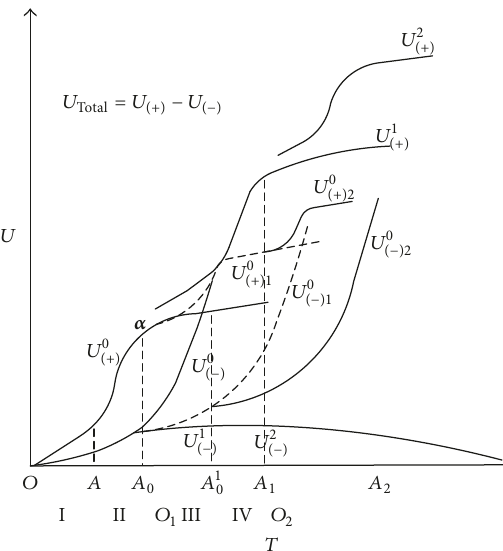
Figure 3: Long-term development trend of railway